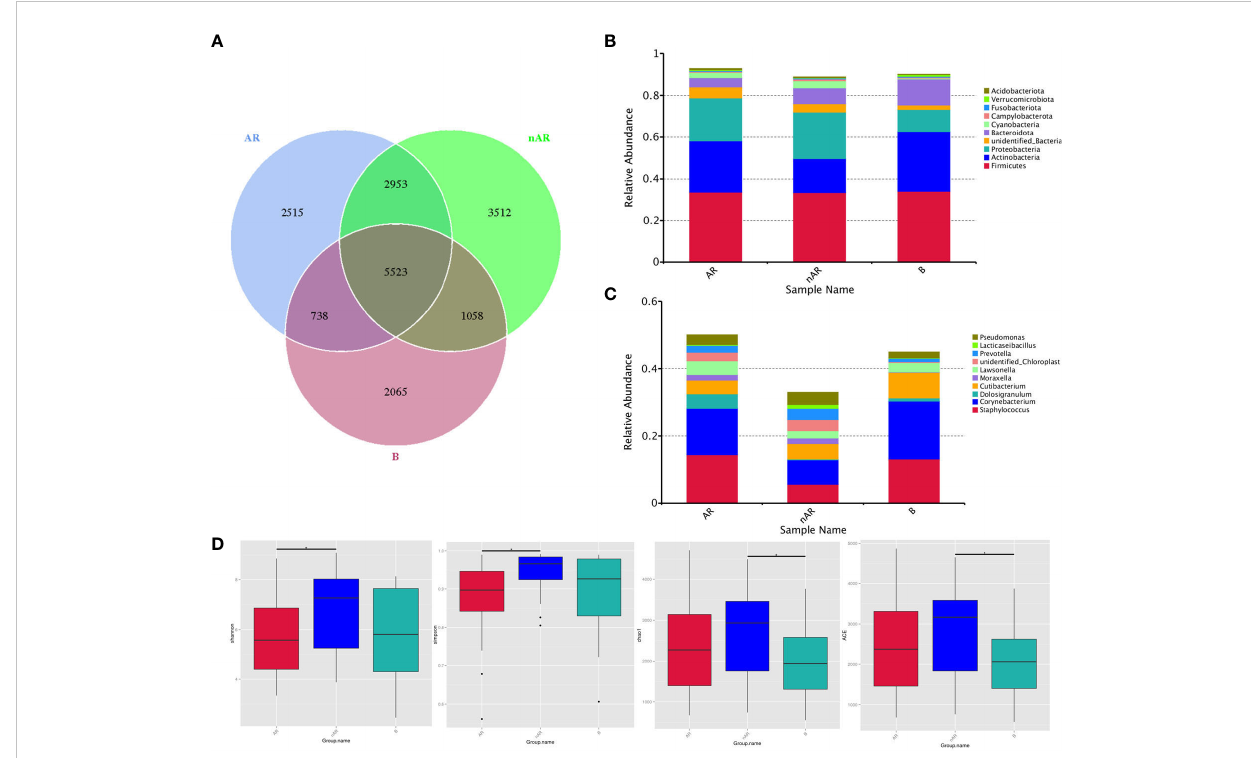
FIGURE 1 Wayne diagrams were made according to OTU (A) . bacterial structure comparisons between AR and non-AR at the phylum (B) and genus (C) levels, including the top ten genera. bacterial diversity comparisons between AR and non-AR patients. Comparison of bacterial alpha diversity indices, including Shannon, Simpson, Chao1, and ACE (D)